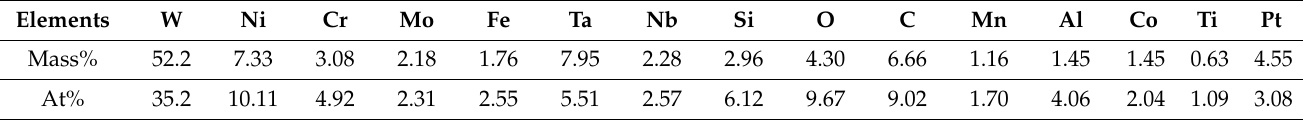
Table 2. Elemental composition of the W nanostructures (highlighted area in Figure 5b).